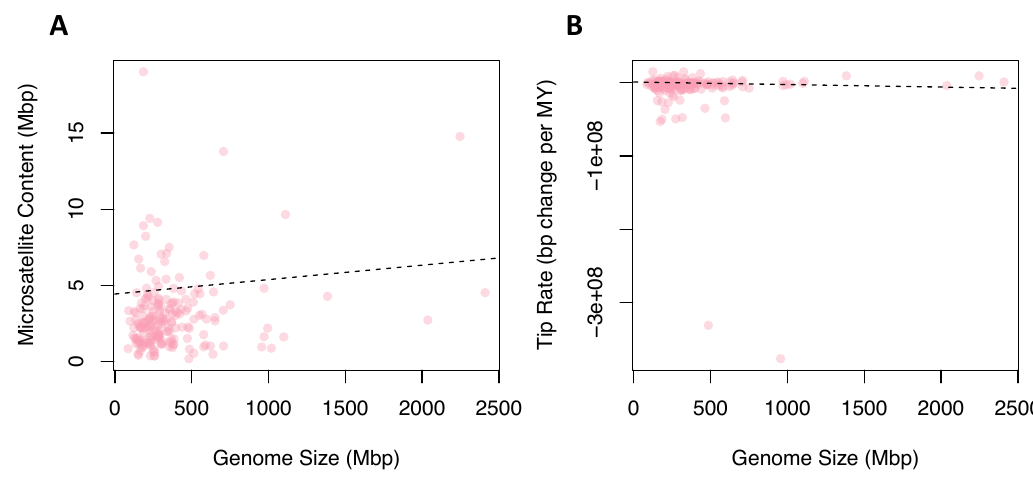
Figure 4. Comparing rates and content to genome size. ( A ) The relationship between microsatellite content in Mbp and the genome size in Mbp for each species. ( B ) The relationship between microsatellite evolution rates and the genome size in Mbp for each